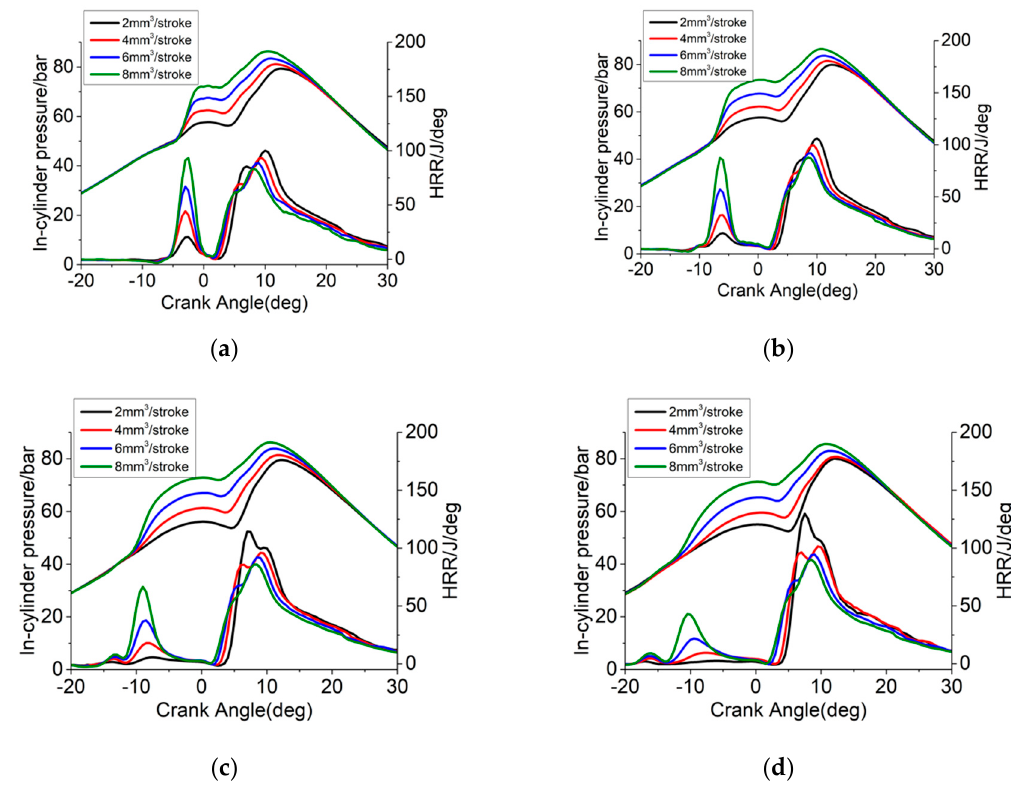
Figure 2. In-cylinder pressure and heat release rates. ( a ) Pilot injection timing = − 9° ATDC; ( b ) pilot injection timing = − 14° ATDC; ( c ) pilot injection timing = − 19° ATDC; ( d ) pilot injection timing = − 24° ATDC.